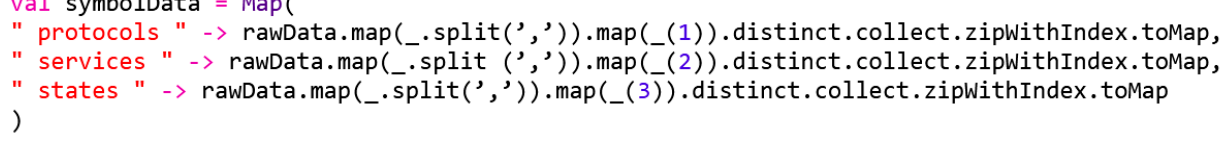
Figure 7. Transformation of categorical characteristics into three indexed map instances.